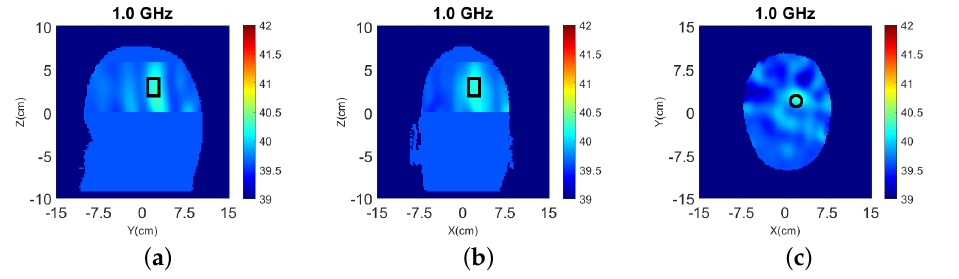
Figure 21. 3-D reconstructions of (cid:60) ( ε r ) for Case III.2 at 1.0 GHz: ( a ) y-z slice, ( b ) x-z slice, and ( c ) x-y slice, same as Figure 17 but with vectorial Green’s functions in